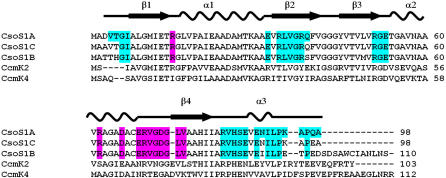
Alignment of the Amino Acid Sequence of H. neapolitanus CsoS1A to Its Paralogs and to the Two Syn. 6803 Orthologs of Known StructureAccessible residues on the concave side are in cyan, whereas those on the convex side are in magenta. Accessible residues that are conserved between all three CsoS1 paralogs are also colored in the other species.